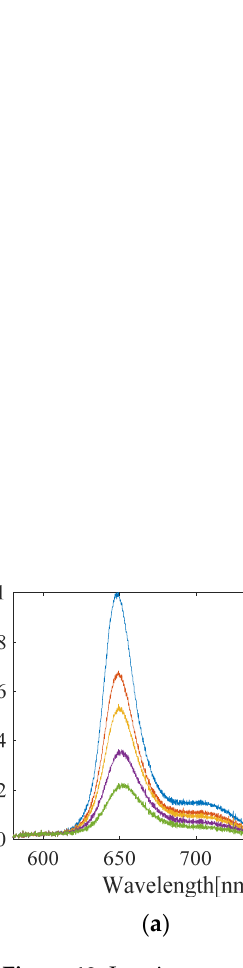
Figure 9. Photostability of PC-PSP after the heat treatment at ( a ) 20 °C and ( b ) 100 °C.